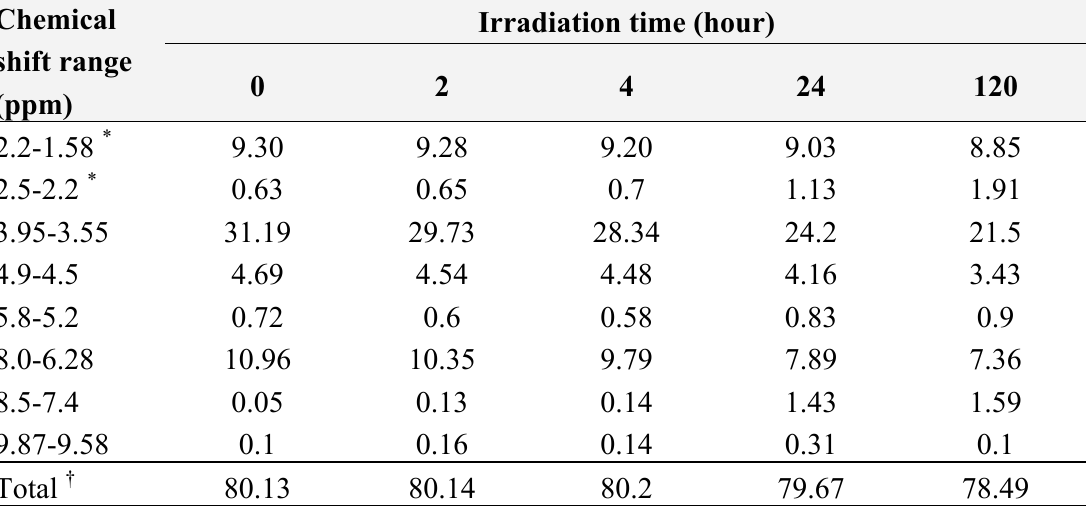
Table 2. The 1 H-NMR data of unirradiated and irradiated BCMP